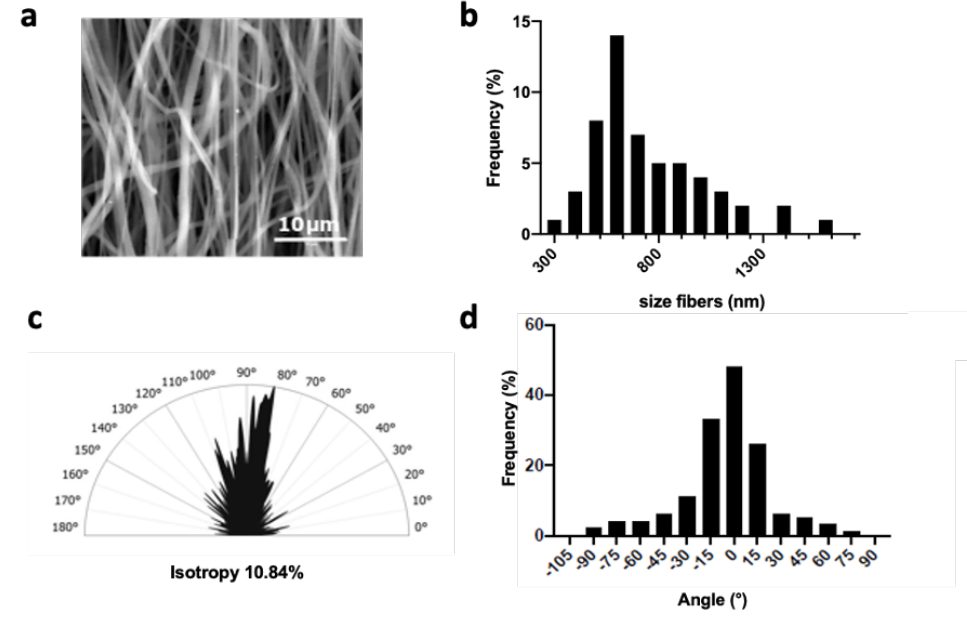
Figure 1. Characterization of electrospun fibers. ( a ) SEM images showing the electrospun fibers, ( b ) fiber size distribution ( n = 100 fibers), ( c ) analysis of fiber orientations according to the principal directions using Fourier transform, and ( d ) half-polar smoothed curve of the orientation of the fibers from SEM image analysis ( n =